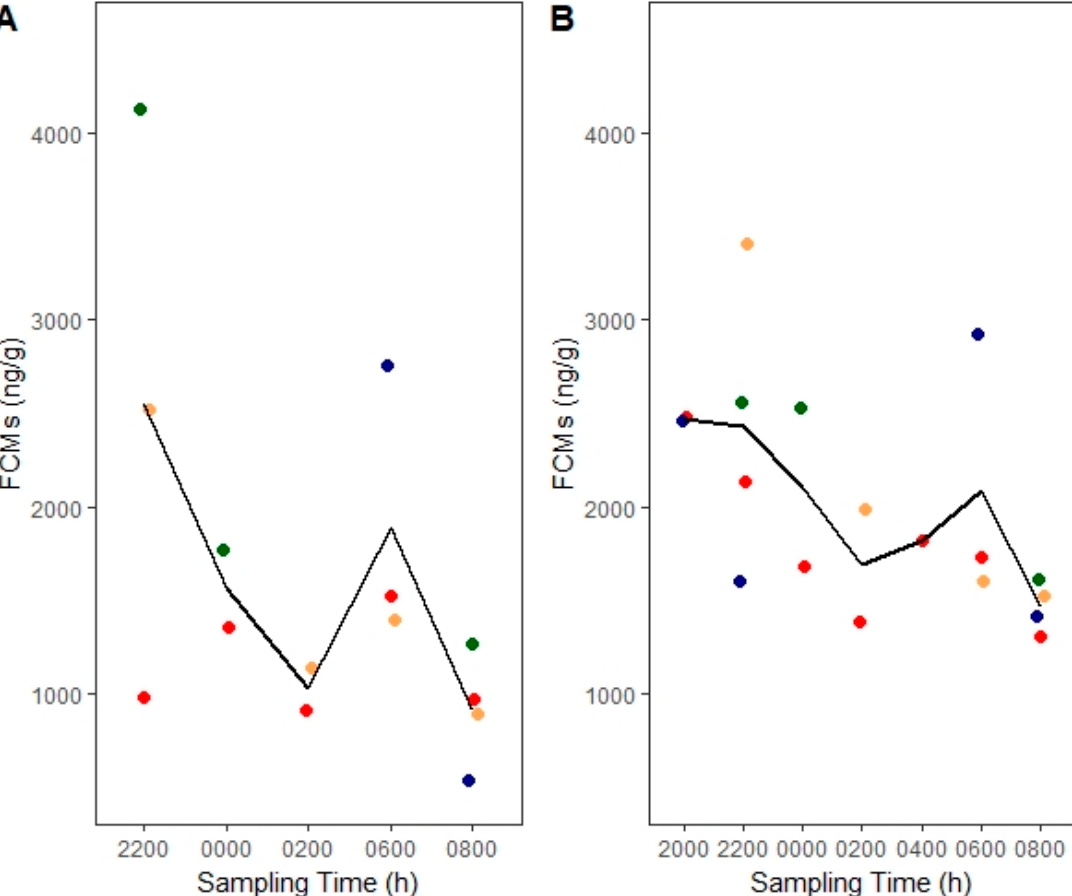
Figure 2. Changes in corticosterone baseline fecal cortisol/corticosterone metabolites (FCMs) from laboratory-bred deermice across the dark cycle measured with ( A ) corticosterone enzyme immunoassay (EIA) and ( B ) group-specific EIA. Lines connect means from each sampling time and circles indicate data points whereby an individual is denoted with a different color. Males are shown in blue and green colors, whereas females are shown in red and tan.